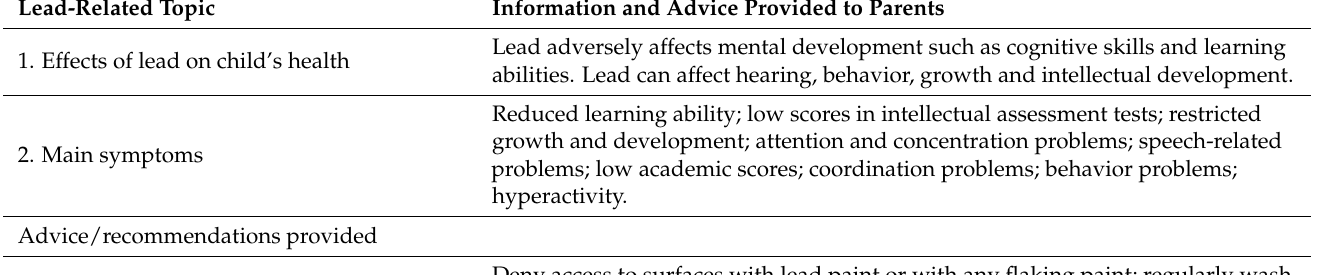
Table 1. Brief description of the information and advice/recommendations provided to parents. Lead-Related